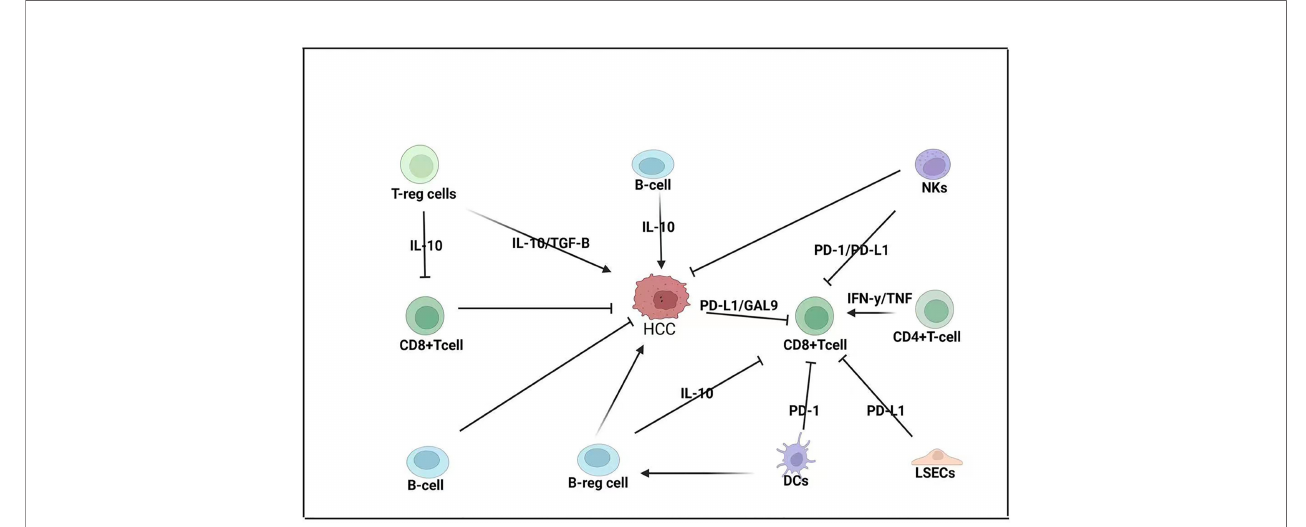
FIGURE 2 | Adaptive immune response in HCC-BM. CD8 + T cells are considered the primary anti-cancer cells in HCC pathogenesis but their function is modulated by both the TME and the innate immune system. CD8 + T cells are modulated by regulatory T cells (T-reg cells) that express interleukin 10 (IL-10); T-reg cells can also promote the expression of transforming growth factor beta (TGF-B), which promotes HCC. Regulatory B cells (B-reg cells) can also directly promote HCC by expressing IL-10 or modulating CD8 + T-cell expression. HCC tumors can express programmed death ligand-1 (PD-L1) and galactin-9 (GAL-9) to repress CD8 + T cells that can also be repressed by liver sinusoidal endothelial cells (LSECs) that can express PD-L1 and dendritic cells (DCs) that express programmed cell death protein 1 (PD-1). Natural killer (NK) cells can repress both CD8 + T cells and HCC